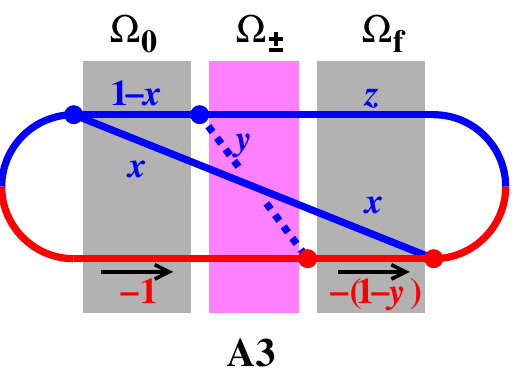
Figure 15 . The A3 diagram with shading denoting the initial 3-particle evolution (left), the 4-particle evolution (middle), and the final 3-particle evolution (right). Our names Ω for the corresponding complex harmonic oscillator frequencies are marked atop each